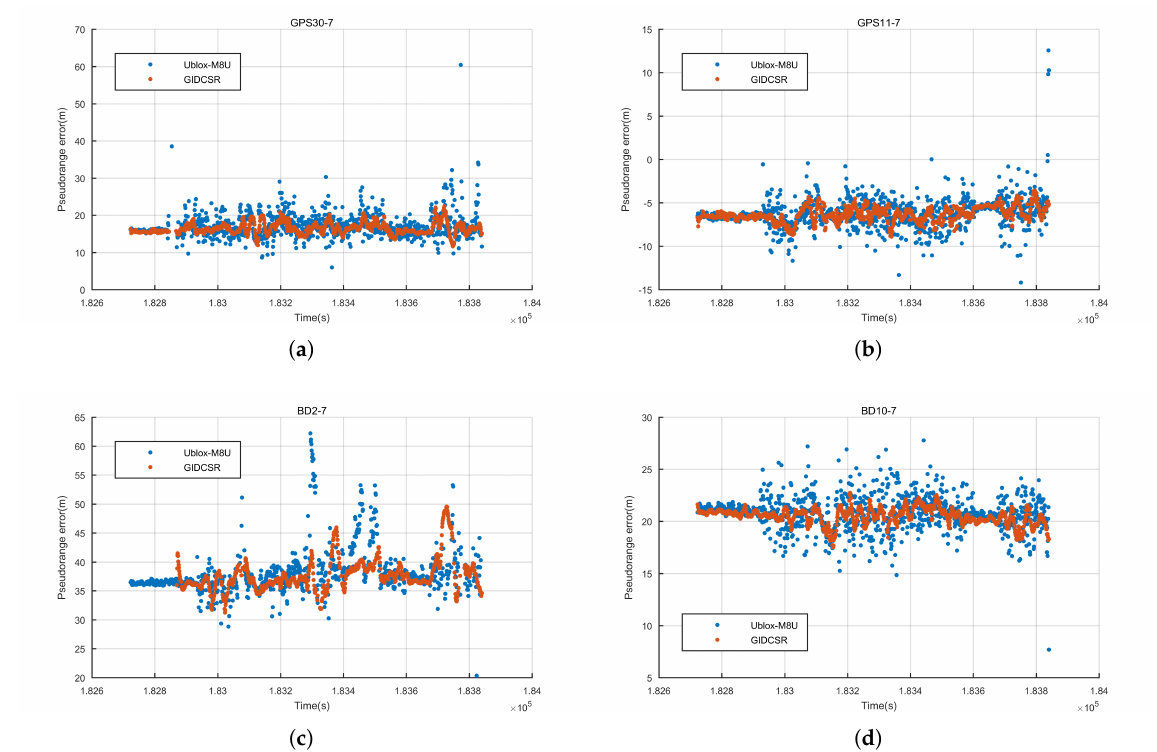
Figure 18. Pseudo-range errors (m) of some satellites. ( a ) GPS satellite 30 with low elevation ( b ) GPS satellite 11 with high elevation ( c ) BD satellite 2 (GEO) ( d ) BD satellite 10